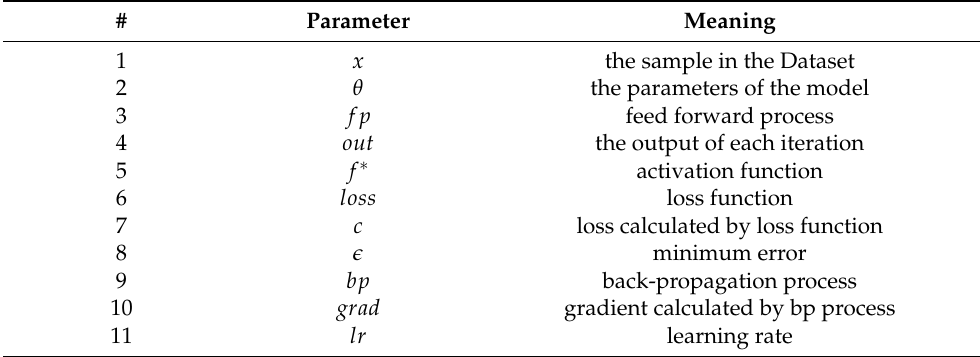
Table 1. The parameters and descriptions in the PFMLP